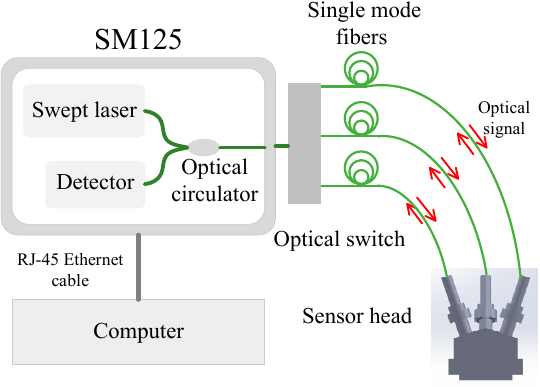
Figure 3. A schematic diagram of the experimental setup. Three input–output channels are connected to the three single mode fibers, which terminate and form three EFPIs in the sensor head. An integrated optical switch is used for rapid switching between EFPIs.